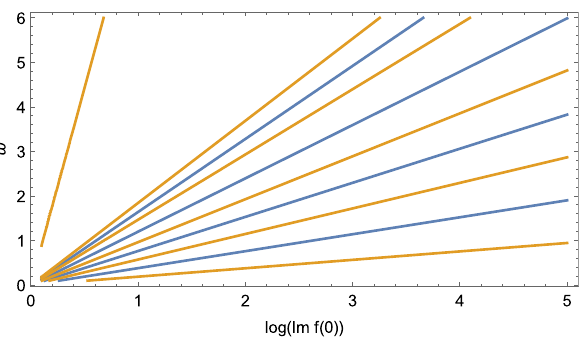
Fig. 6 The plots of absolute value (blue) and real and imaginary parts (orange) of G (ω, 1 ) over ω in the d = 6 parabolic case. We cannot identify any zero for ω > 0